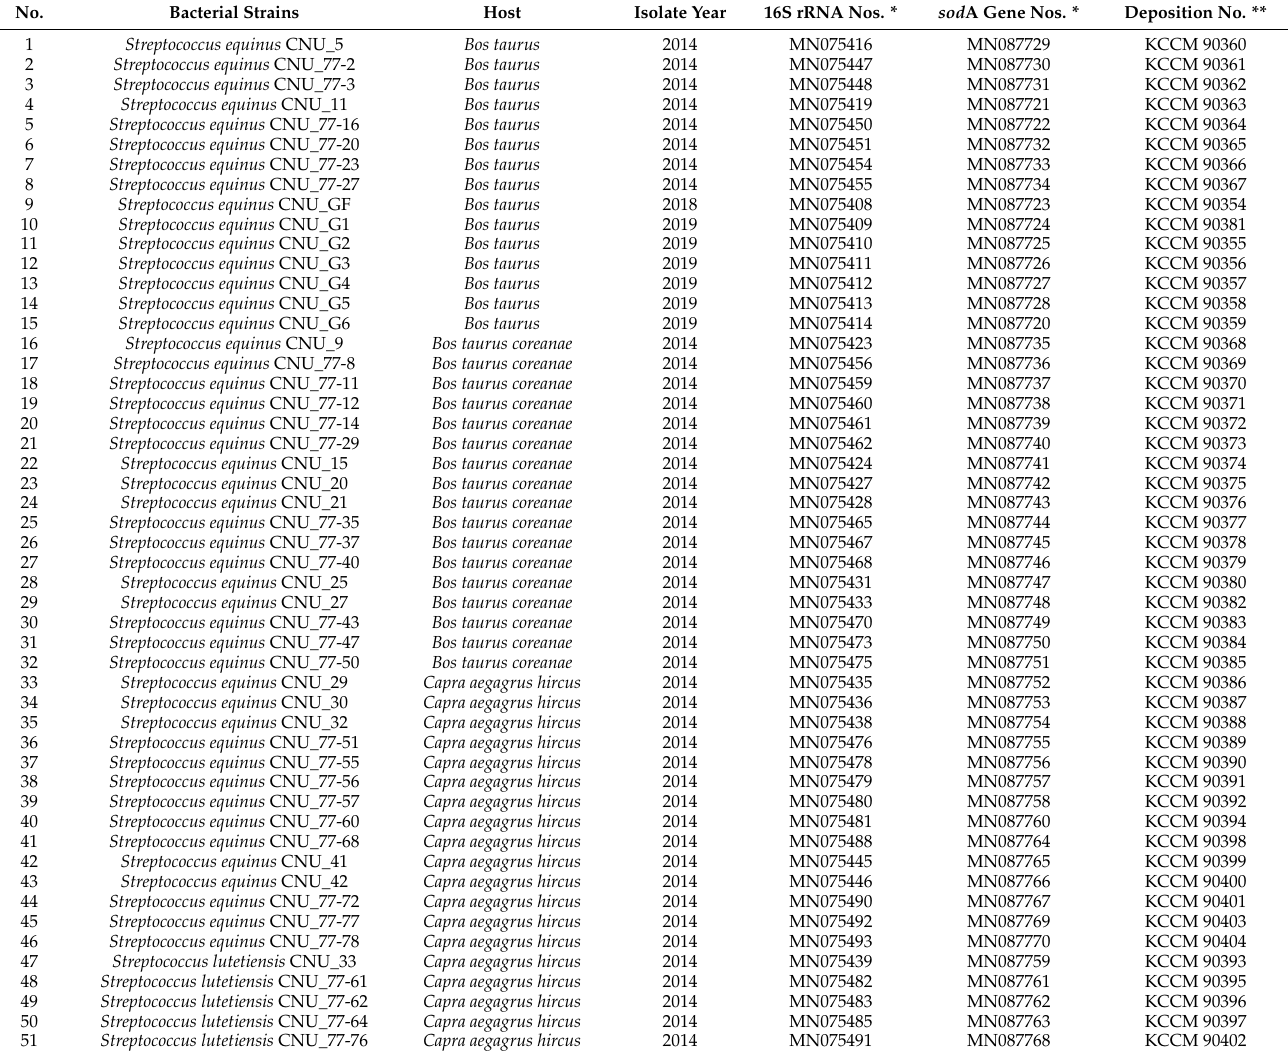
Table 1. S. bovis / S. equinus complex (SBSEC) isolates obtained in this